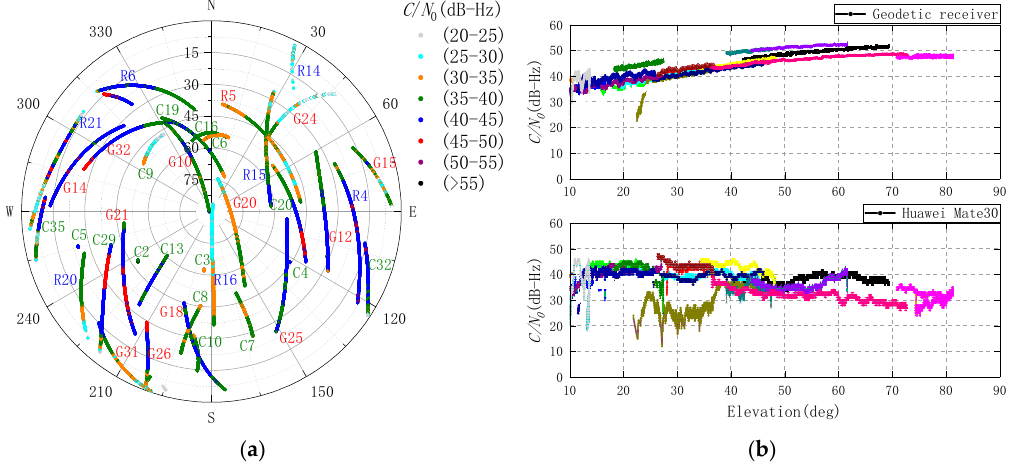
Figure 2. Huawei Mate30 sky plot and the GNSS satellites C/N 0 values of the geodetic receiver and Huawei Mate30. ( a ) Each color corresponds to the C/N 0 range of GNSS L1 band signal. ( b ) The same color on the top and bottom represents the same GNSS satellite. The G, C, and R denote GPS, BeiDou (BDS), and GLONASS, respectively.